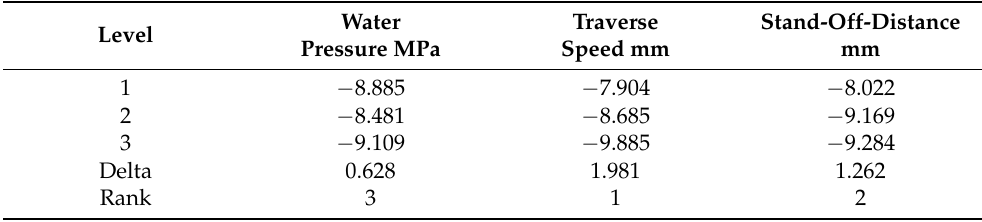
Table 20. S/N ratio response table of input cutting parameters of the 4 mm thickness off